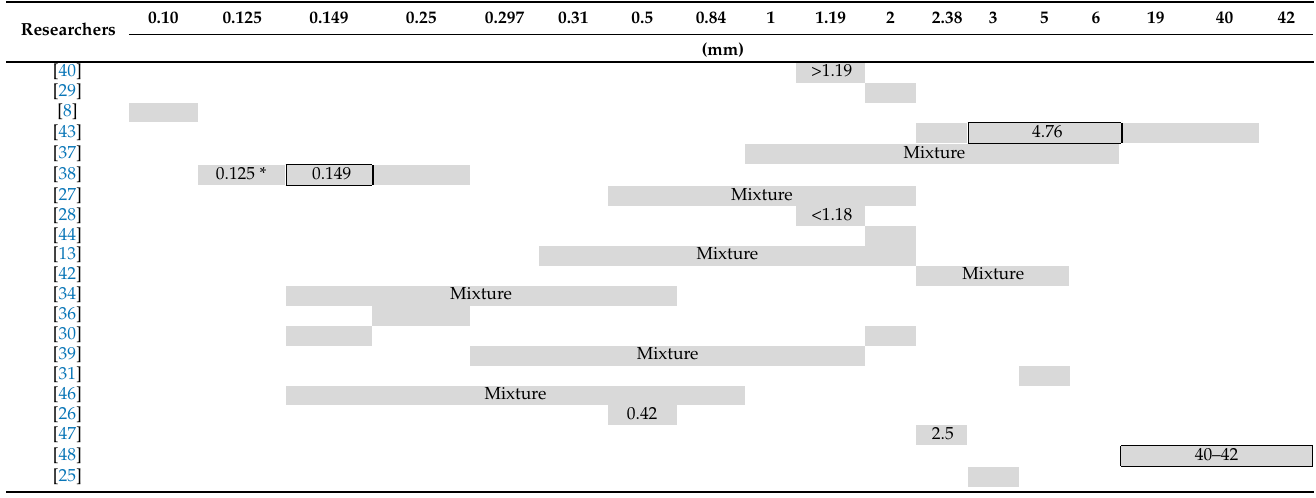
Table 9. Granulometry levels of the biomass used for the production of